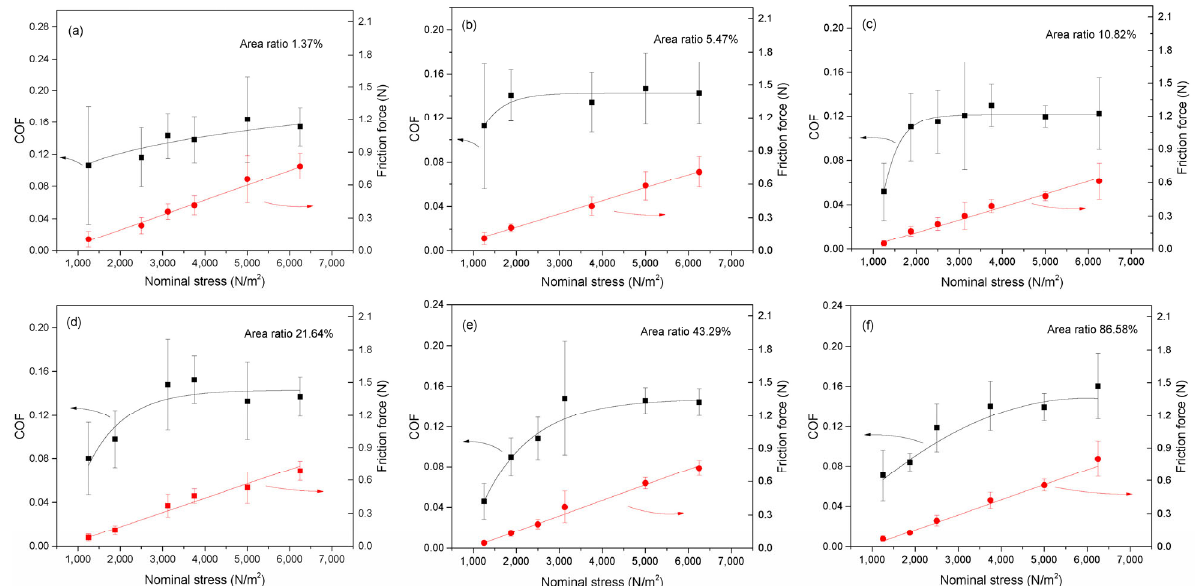
Fig. 10 Variation of the mean COF and friction force with increasing nominal stress in different area ratio. (a) 1.37%, (b) 5.47%, (c) 10.82%, (d) 21.64%, (e) 43.29%, and (f)